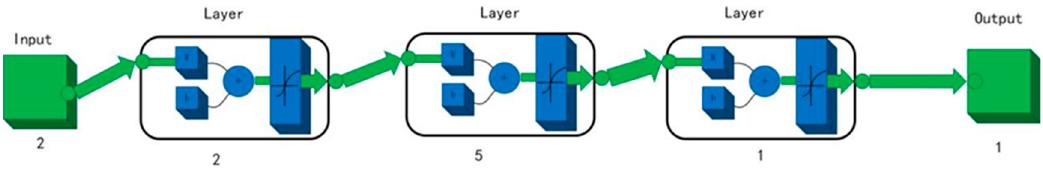
Figure 5. Structural diagram of the BP neural network. Table 8. Forecast results.